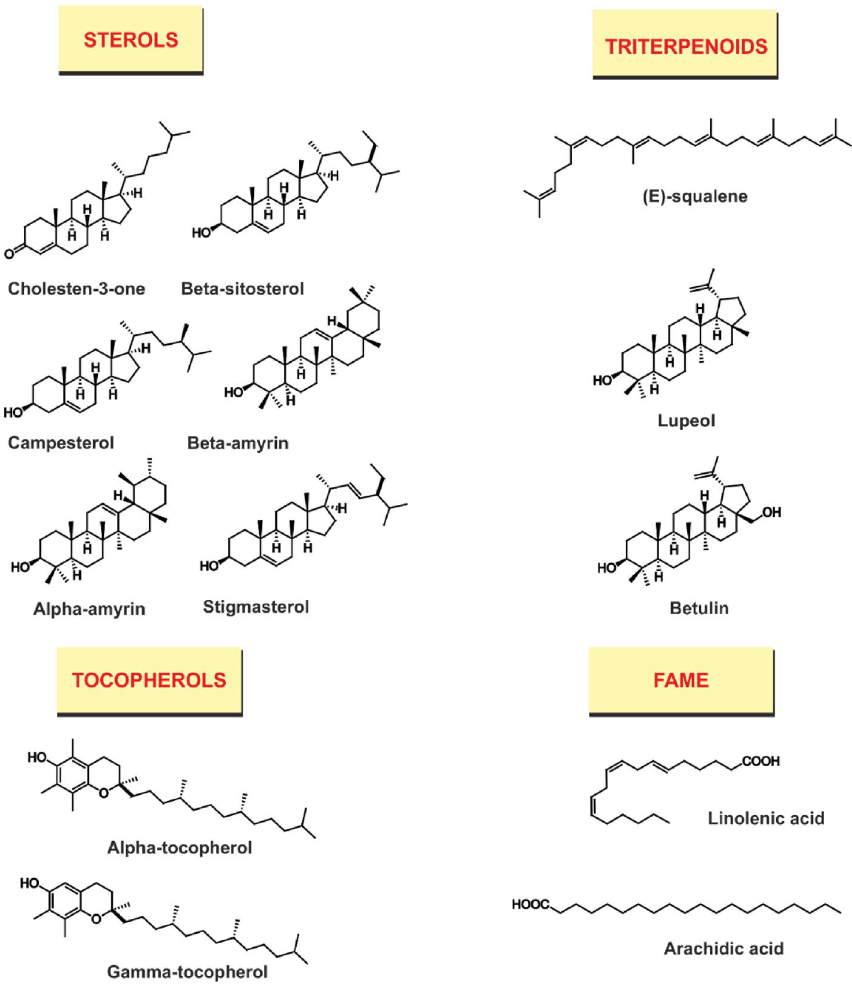
Figure 2. The structures of the main classes of metabolites identified in the n -hexane extract of O. vulgare .